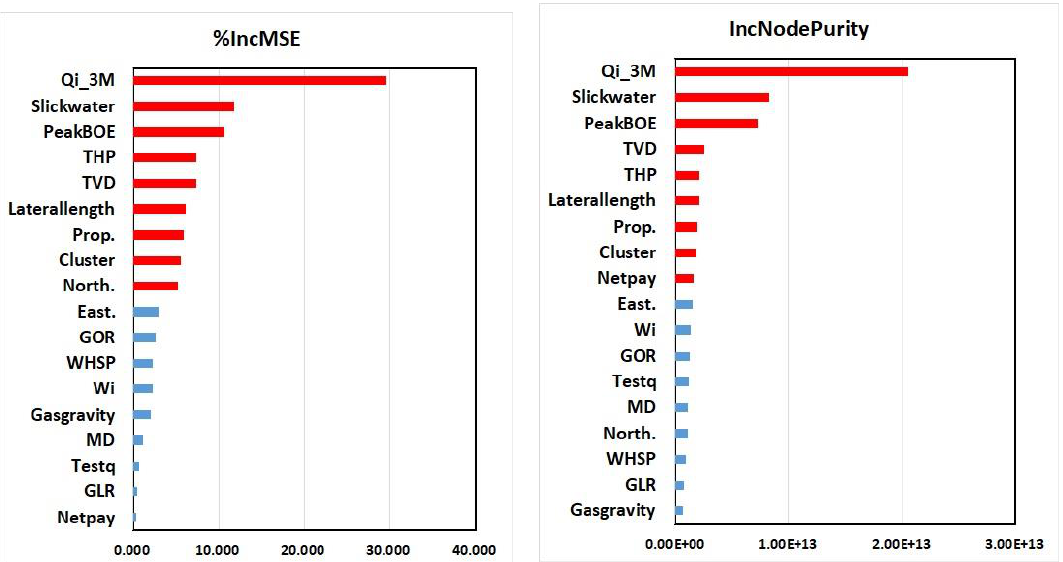
Figure 8. Variable importance analysis results by random forest (%IncMSE and IncNodePurity).